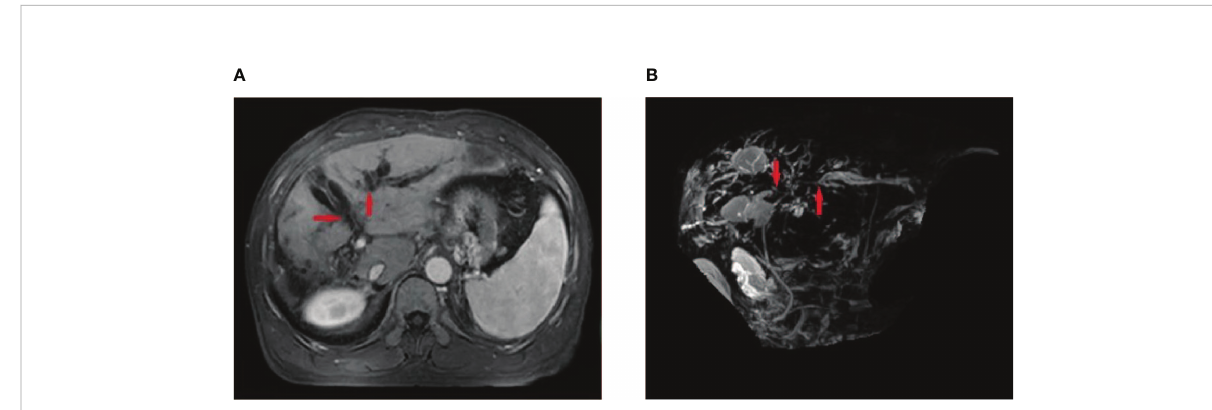
(Figure 4). The nomogram was validated using the bootstrap method, showing consistency between the predicted and experimental values (Figure 5), and the model performed well in the Hosmer-Lemeshow goodness-of- fi t test ( c 2 = 3.648; P=0.887), indicating its superior predictive ability. The ROC curve of the risk prediction model for predicting bile duct injuries after DEB-TACE among patients with HCC is shown in Figure 6, with an AUC of 0.749 (95% CI, 0.682 – 0.817), an overall accuracy of 69.01%, a positive predictive value of 73.02%, a negative predictive value of 67.87%, a sensitivity of 73.0%,